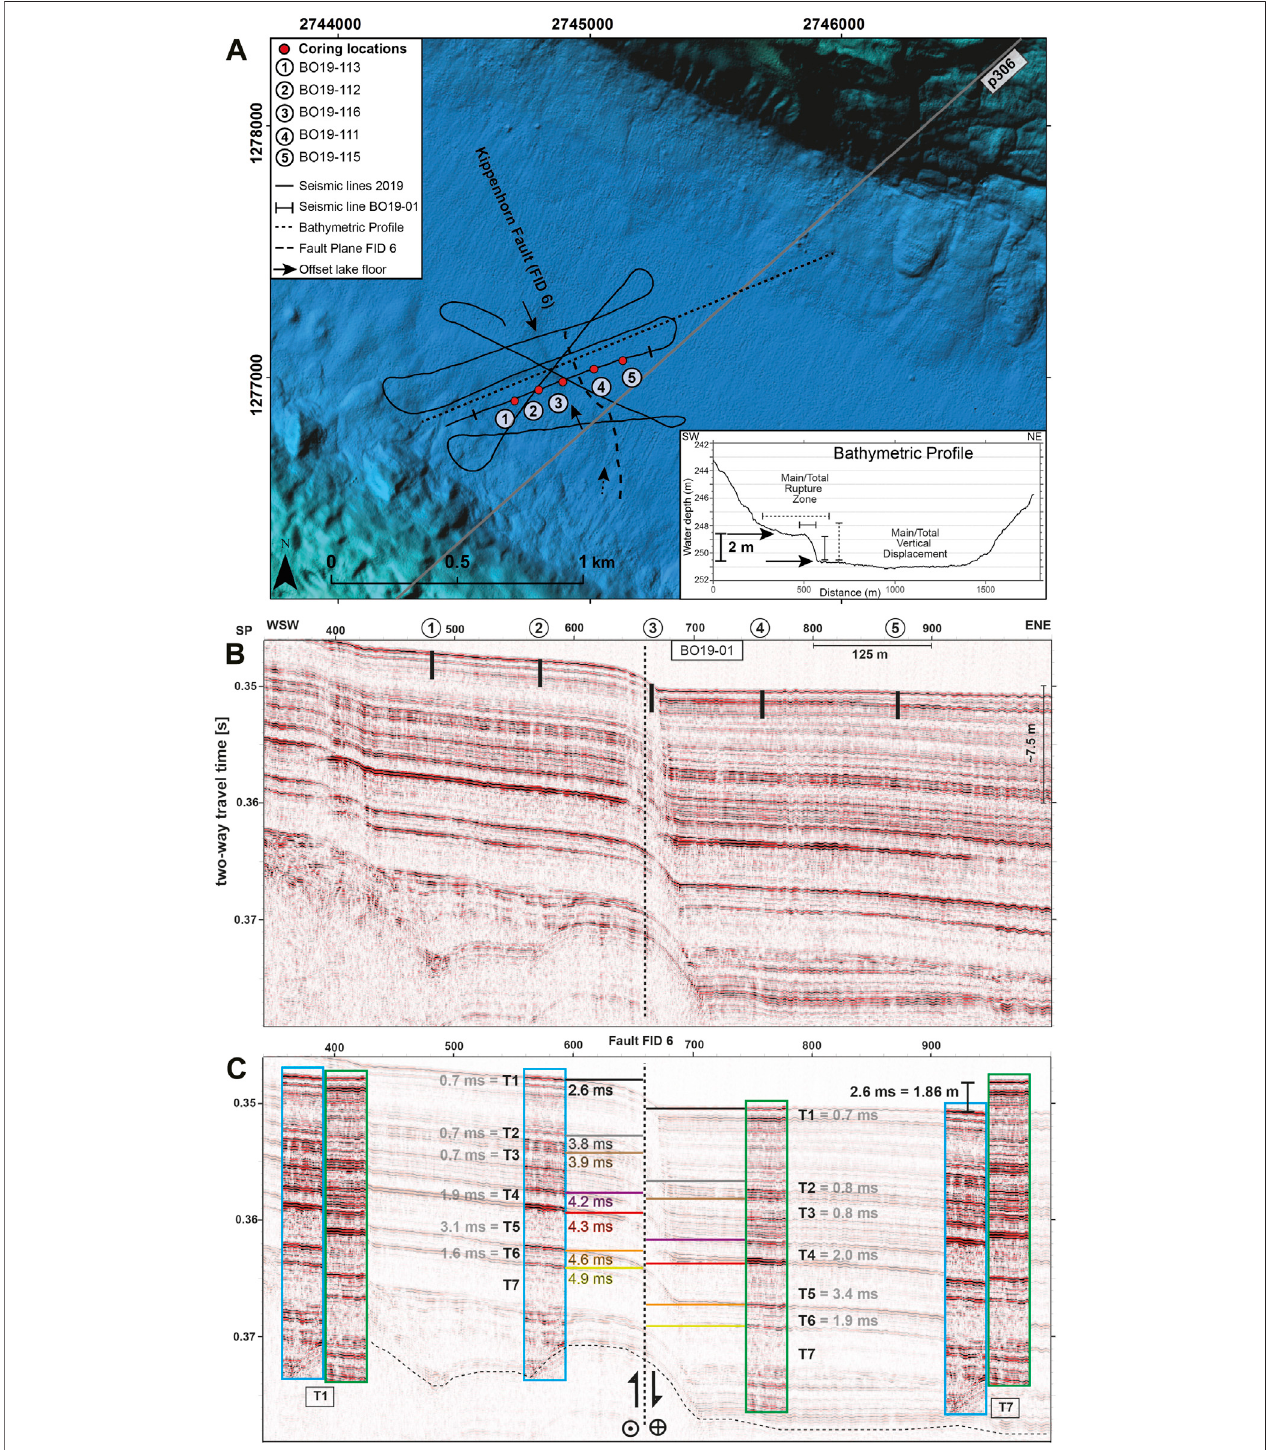
FIGURE12|(A) :Bathymetricmapwithsinglechannel3.5 kHzseismicsurveylinesfrom2019forfaultplaneFID6characterization(blackarrowsmarklakebottom expression).The trace offault plane FID 6 (black dashed line) isprojected onto the lake bottom from 400 ms twt depth. Locations ofshort cores (1 – 5) are indicated. See Supplementary TableS7 formoredetails. Seismicsection p306isshown in Figure7 .Extent ofthe fi gure isshown in Figure 10 .Inset:Bathymetric pro fi lehighlighting lake-bottomoffset. (B) :Seismicsectionwithshortcorelocationssuperimposed.C:Turbidite(T1-T7)correlation acrossthefaultplaneFID6andoffsetcomparison offootwallwithhangingwall(color-codednumbers).ThicknessofT1-T7oneithersideofthefaultisgiveningreynumbers.Cumulatedsedimentationdifferencebetween foot- and hanging wall amounts to ∼ 2 m (based on a water column sound speed of 1,428 m/s, see Supplementary Table S3 ) at the lake bottom, indicative for the power of turbidities to level out offsets over time. Figures 4 , 9 show the deeper structure of this section (dotted line). Horizon offsets (color-coded twt) increase with